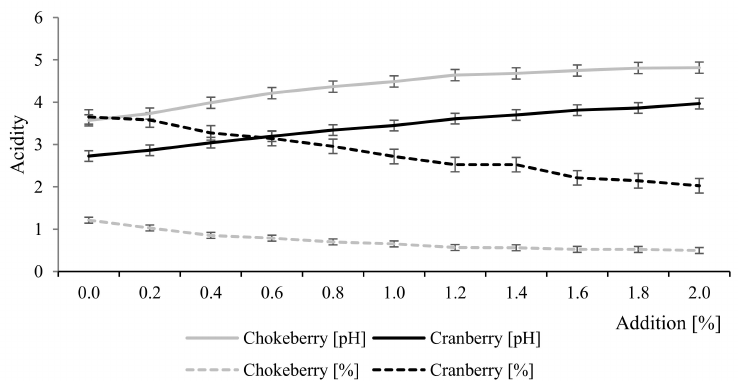
Figure 2. The e ff ect of the addition of eggshells on acidity changes in berry fruit juices before thermal